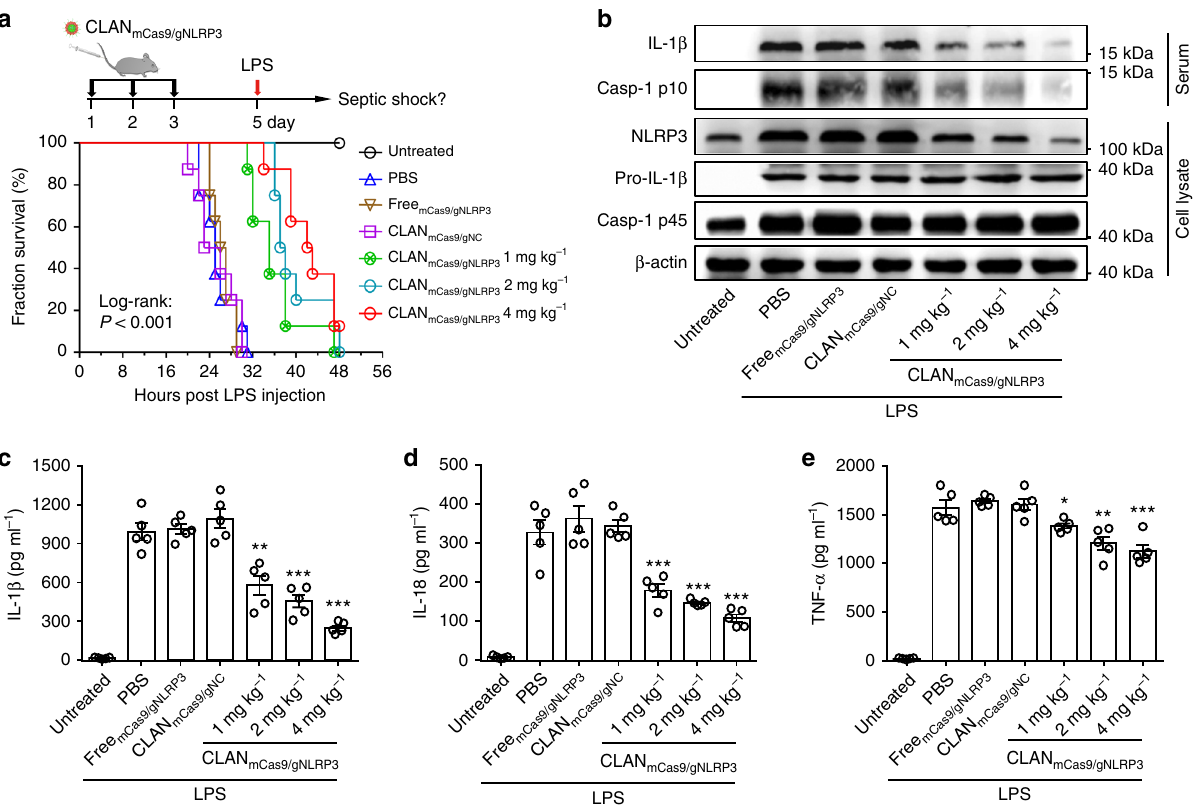
Fig. 5 Mitigation of LPS-induced septic shock via CLAN mCas9/gNLRP3 -mediated NLRP3 knockout. a Therapy scheme and mouse survival curve of LPS- induced septic shock. n = 8 per group. b – e Immunoblot analysis of serum and peritoneal macrophage lysates ( b ) or ELISA of the IL-1 β ( c ), IL-18 ( d ), TNF- α ( e ) concentration in serum from mice pre-treated with CLAN mCas9/gNLRP3 or other formulations and then challenged with LPS. The data are representative of two independent experiments ( b ) or are shown as the means ± SEM of n = 5 ( c – e ). Log-rank test ( a ) Two-way ANOVA ( c – e ) * P < 0.05, ** P < 0.01, *** P <